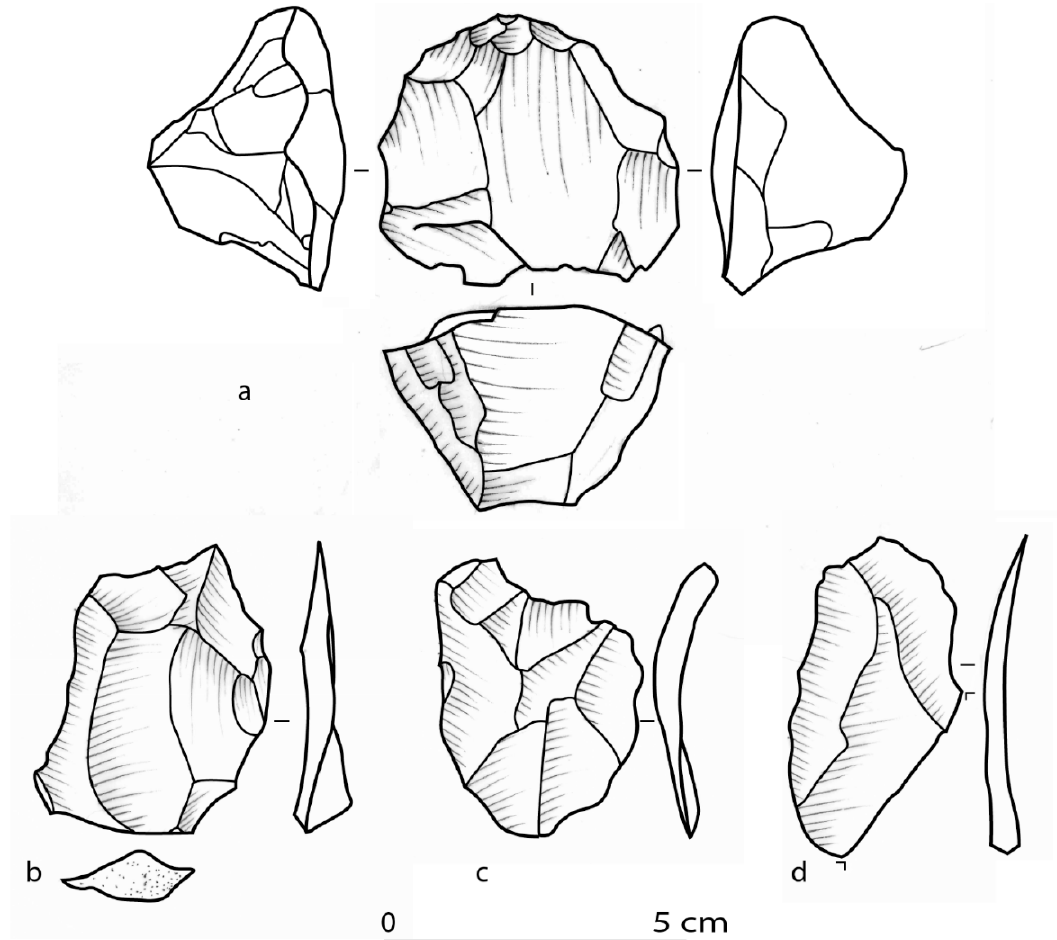
Figure 7. Lojanik 2, Levallois elements: ( a ) Preferential Levallois core (found in 2022); ( b – d ) Levallois flakes (from previous surveys).